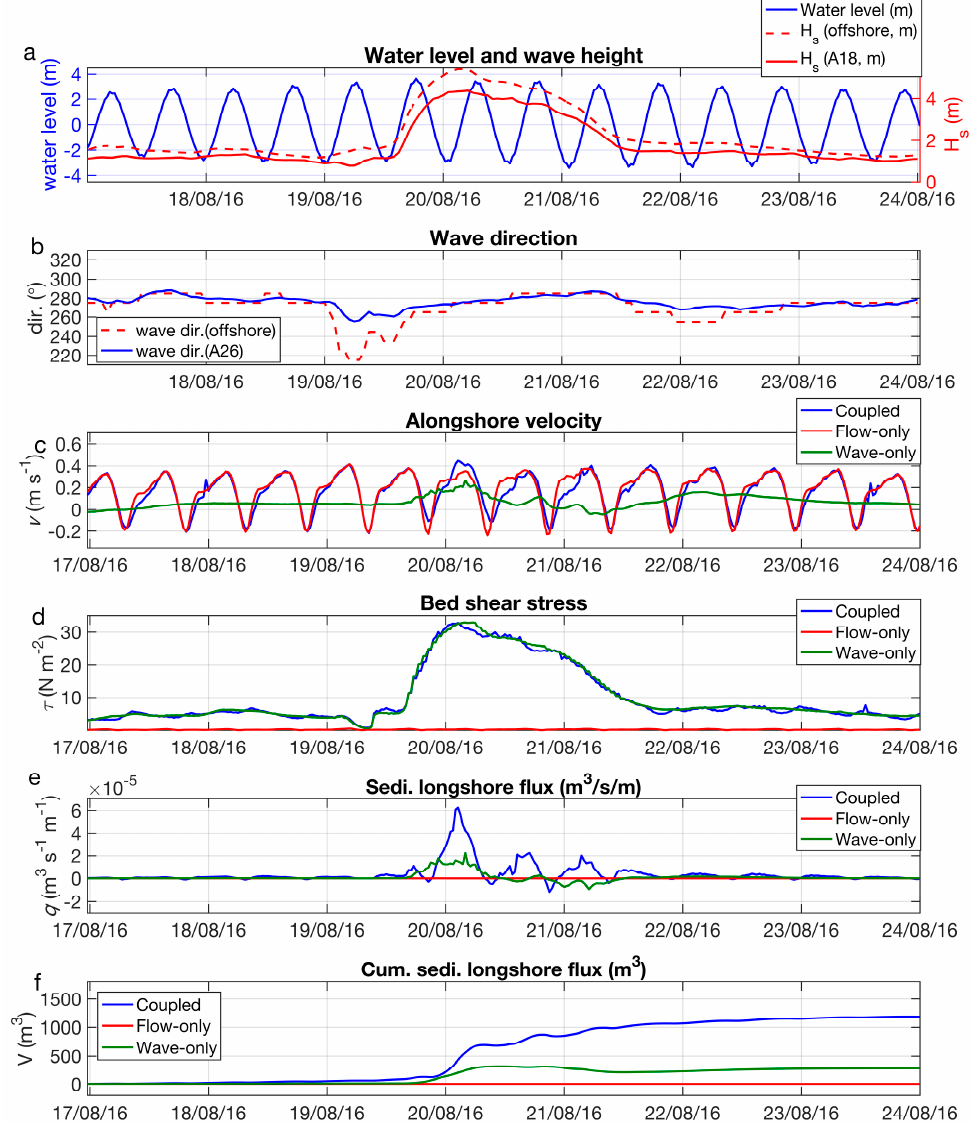
Figure 7. Timeseries of model outputs for ‘Coupled’, ‘Wave-only’, and ‘Flow-only’ simulations, including the following: ( a ) water level [left axis] and wave height [right axis]; ( b ) wave direction; ( c ) alongshore velocity; ( d ) bed shear stress; ( e ) instantaneous sediment volume longshore flux; and ( f ) cumulative sediment volume longshore flux. The variables are averaged ( c , d ) or integrated ( e , f ) over the transect (T1) in Figure 2d.